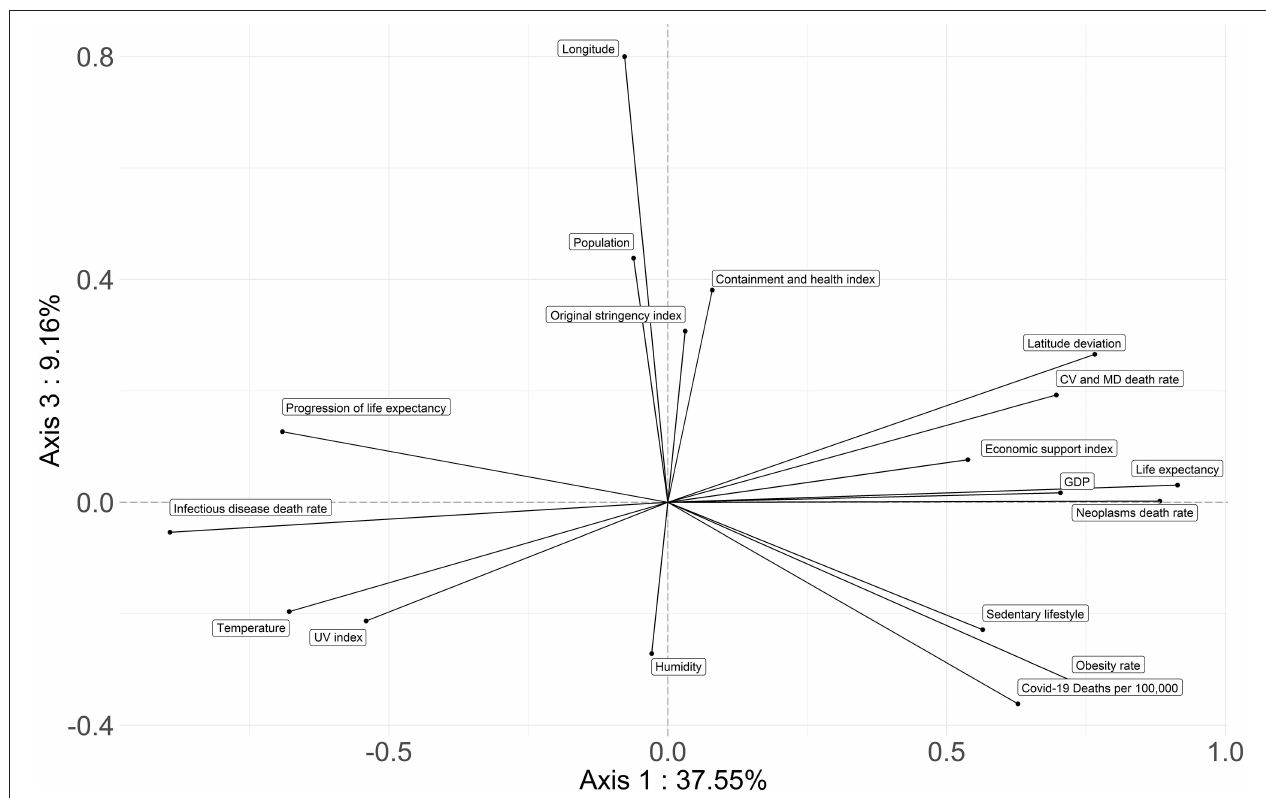
FIGURE 5 | PCA third factorial plane: axis 1 is horizontal; axis 3 is vertical. The studied parameters regrouped the countries associated with Covid-19 highest death rates on the right of the horizontal axis. Longitude and obesity rates are related to the third